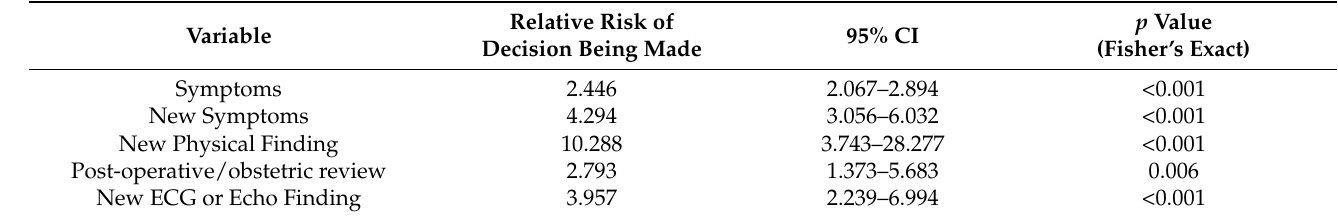
Figure 4. Proportion of clinic appointments during the study period resulting in clinical decision- making or otherwise defined as holding appointments. Table 2. Relative risks of a decision being made in the context of different appointment factors (ECG: electrocardiogram; Echo: